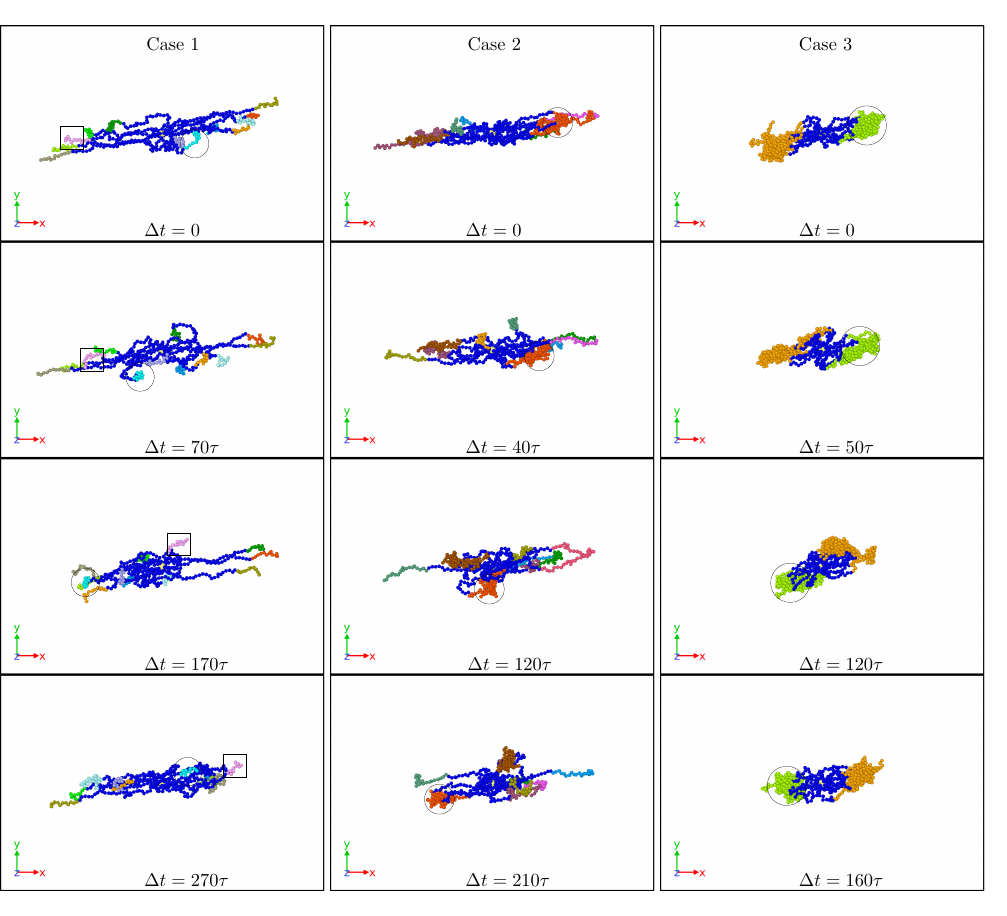
Figure 7. Representative simulation snapshots displaying the time evolution of the star block-copolymer (SBC) in shear flow for { f , α , λ } = { 12, 0.3, 1.0 } (Case 1), { 15, 0.5, 1.1 } (Case 2) and { 18, 0.7, 1.1 } (Case 3). In Case 1, individual arms of the star perform tank-treading motion, while in Case 3, the star tumbles as a whole. Case 2 presents a tank-treading-like motion, but it is performed by both individual and clustered arms. Circles and squares are guides to follow the motion of arms. In all cases, N pol = 40 and Wi = 100. In the panels, ∆ t represents the elapsed time from the first configuration in τ